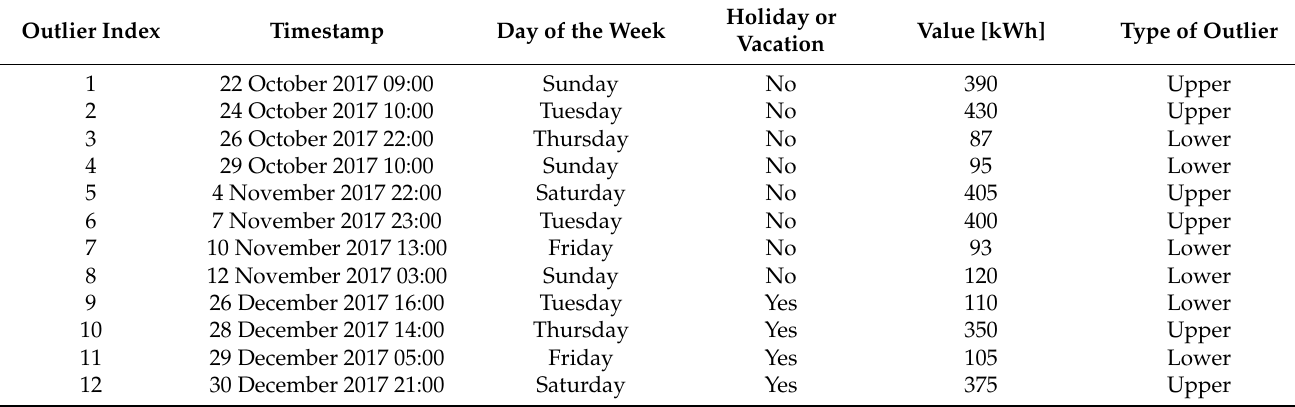
Figure 4. Synthetic GreEn-ER global power consumption with inserted outliers. Table 1. Outliers inserted in the data